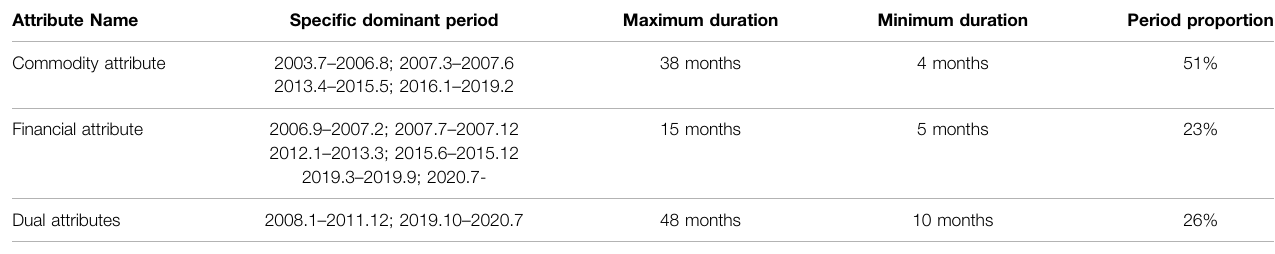
TABLE 2 | Stage characteristics dominated by dual attributes of oil.